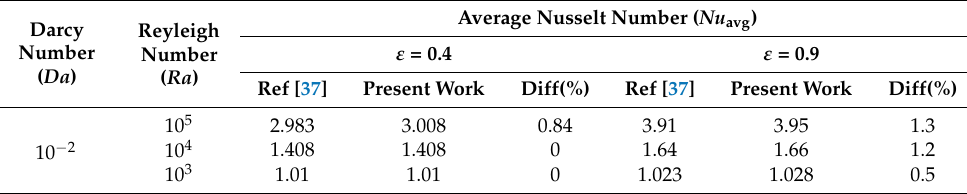
Table 4. Comparison of the average Nusselt number with those of Singh et al. [37] for